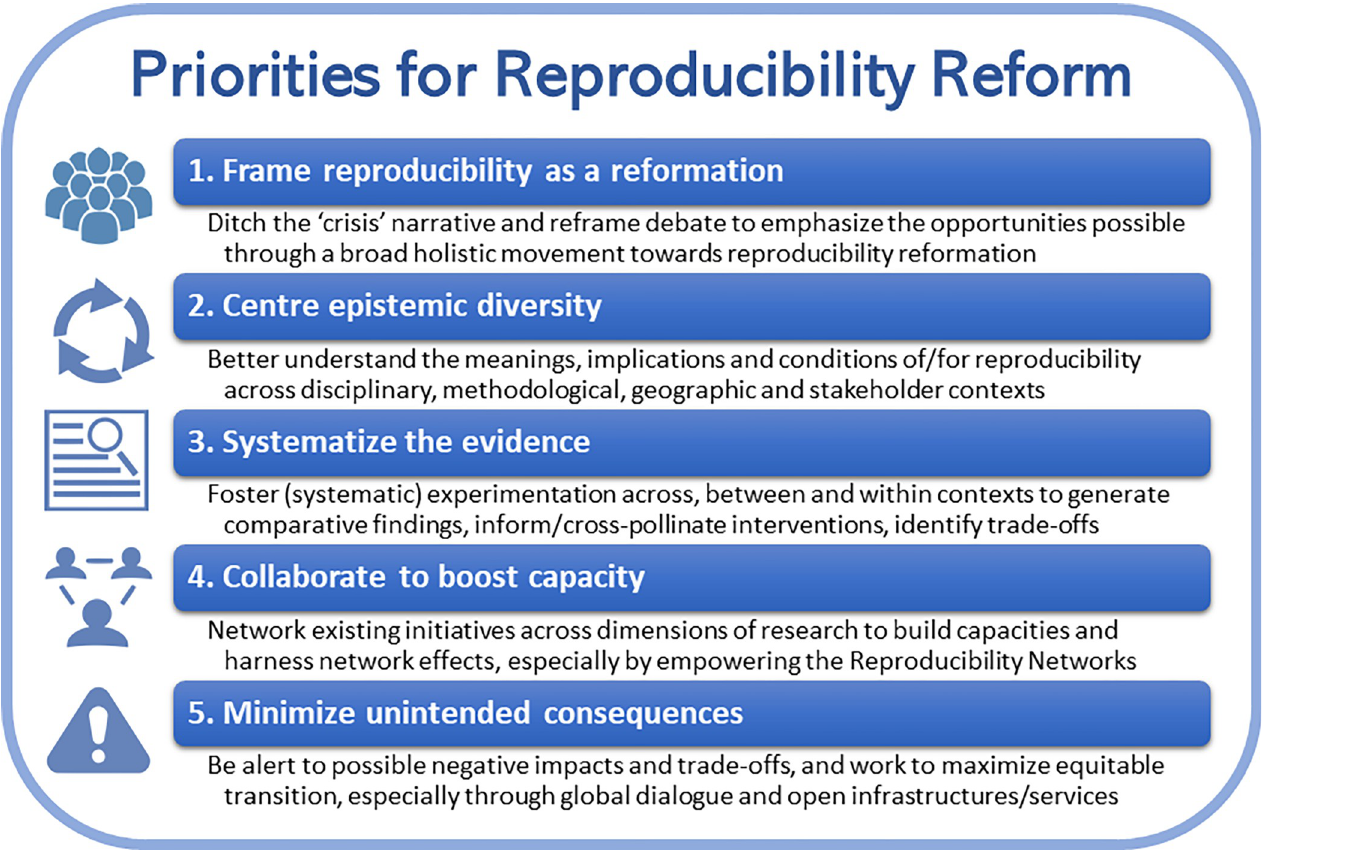
Fig 1. Priorities for reproducibility reform. Brief summary of five proposed strategic priorities to boost reproducibility research in ways which unite efforts, recognize epistemic differences, build an effective evidence base, harness network effects, and minimize unintended consequences. CC BY Tony